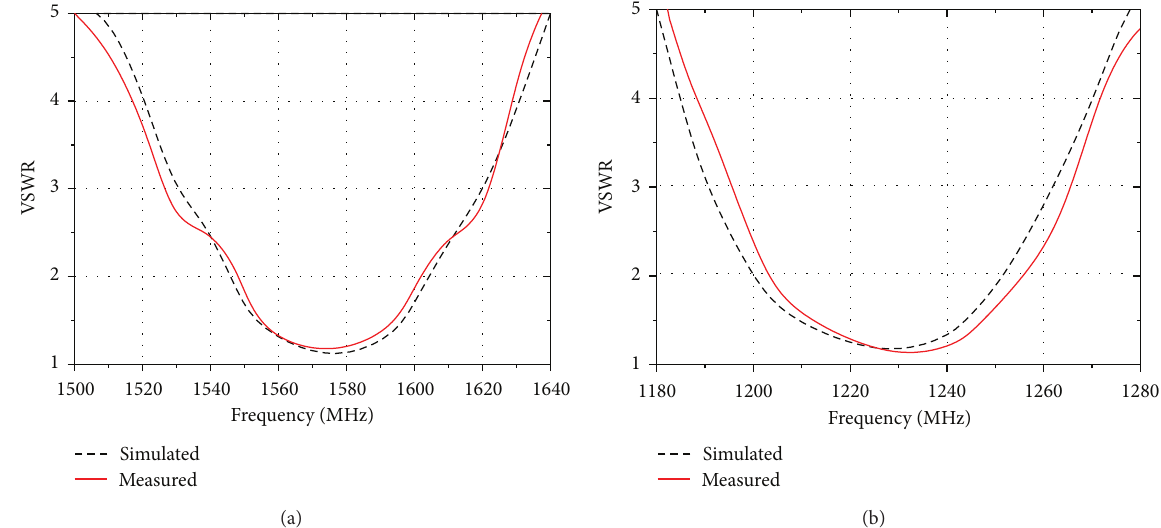
Figure 5: Simulated and measured VSWR of the proposed dual-band CP antenna: (a) L1 band, (b) L2